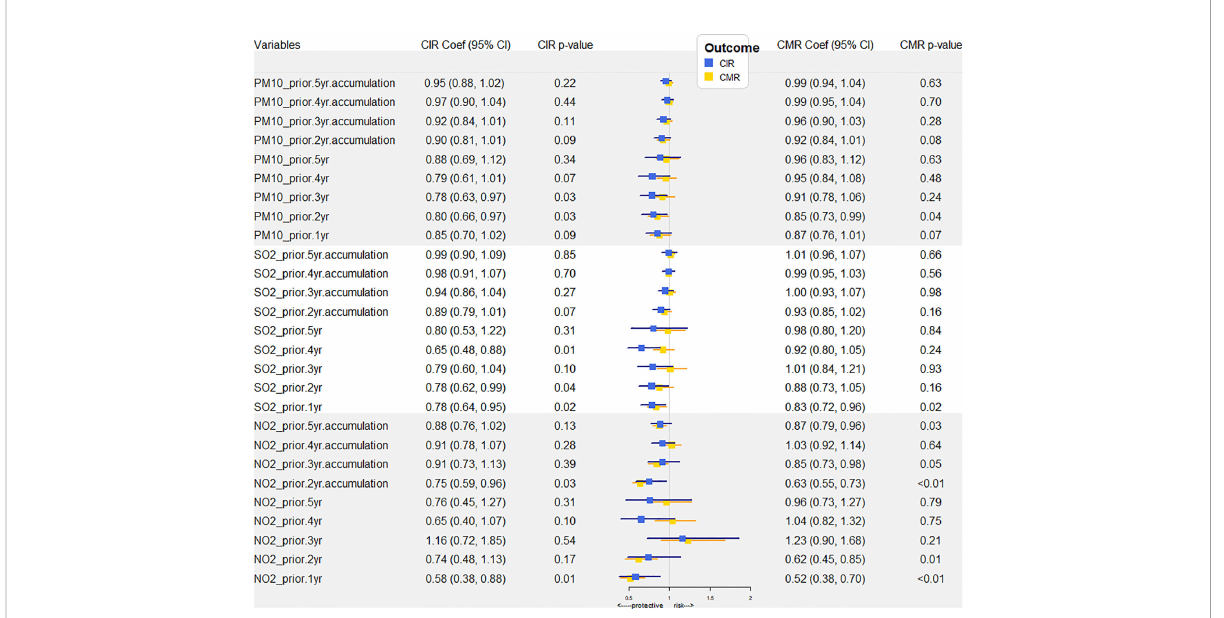
FIGURE 3 Air pollutant exposure-related RRs of CIR and CMR with a 5-year moving window. YAV, yearly average values ( m g/m 3 ); RR, risk ratio (with 95% CI). CIR, crude incidence rate; CMR, crude mortality